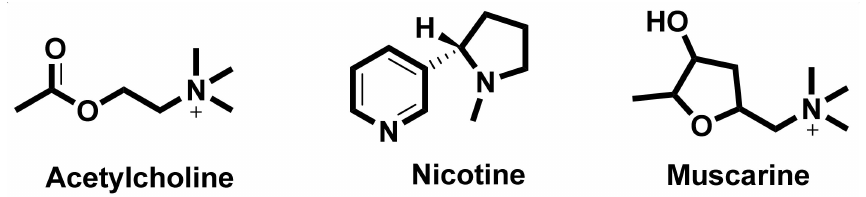
Figure 3. Key molecules comprising the cholinergic